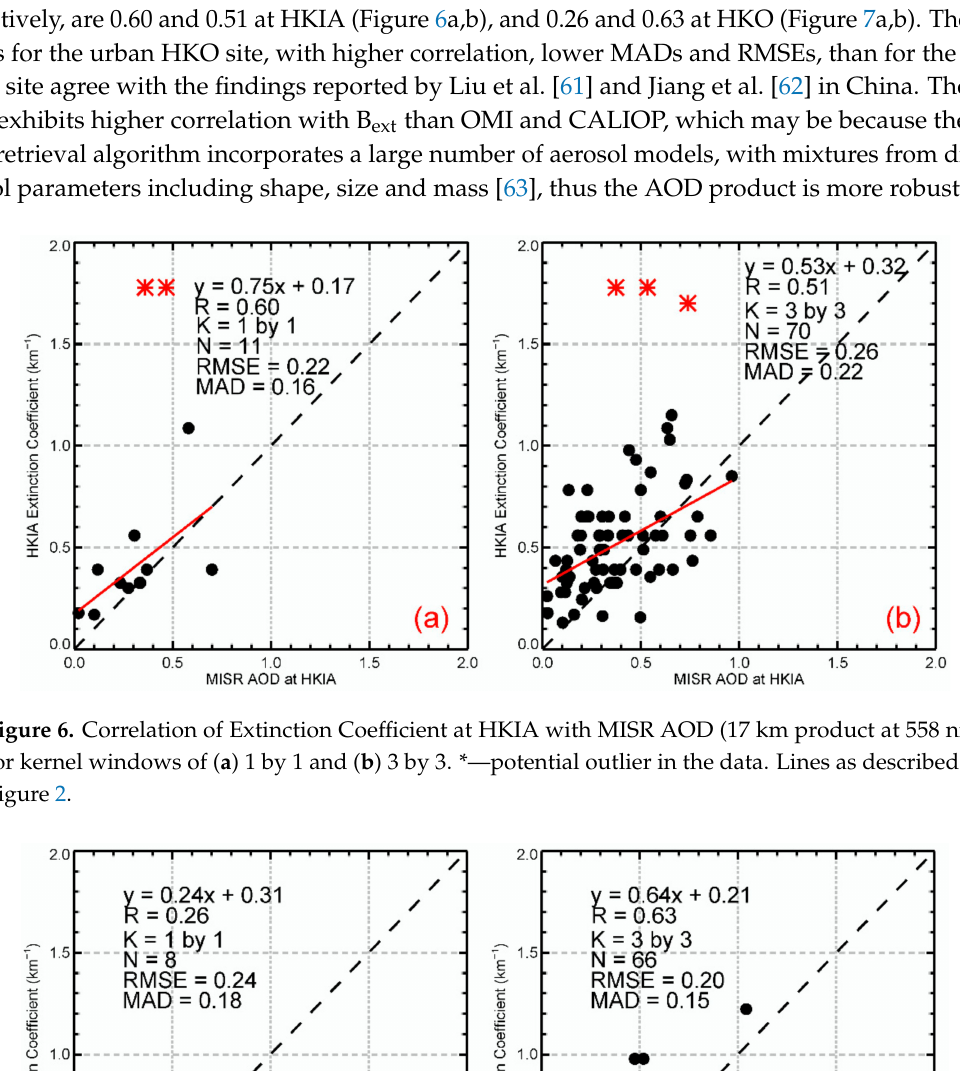
0.26 (Figure 8a–c) at